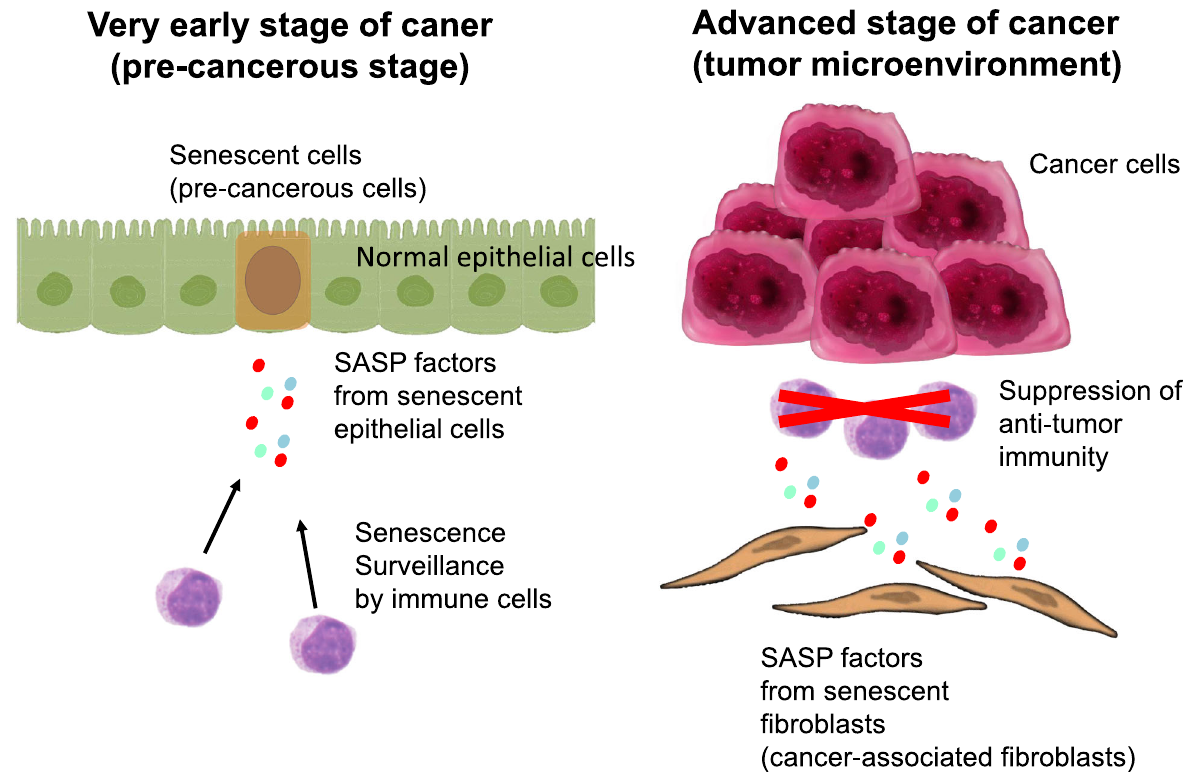
Fig. 3 The role of SASP in tumor microenvironment. The effects of the SASP depends on the tumor stage. In precancerous cells (or in a very early stage of cancer), which are known to be in the senescent state, the effects of the SASP factors from the precancerous cells are predominantly tumor-suppressive, recruiting immune cells to exclude precancerous senescent cells (senescence surveillance). However, in advanced stage of tumor tissues, the SASP factors from senescent cancer-associated fibroblasts (CAFs) support the proliferation of cancer cells and promote tumor